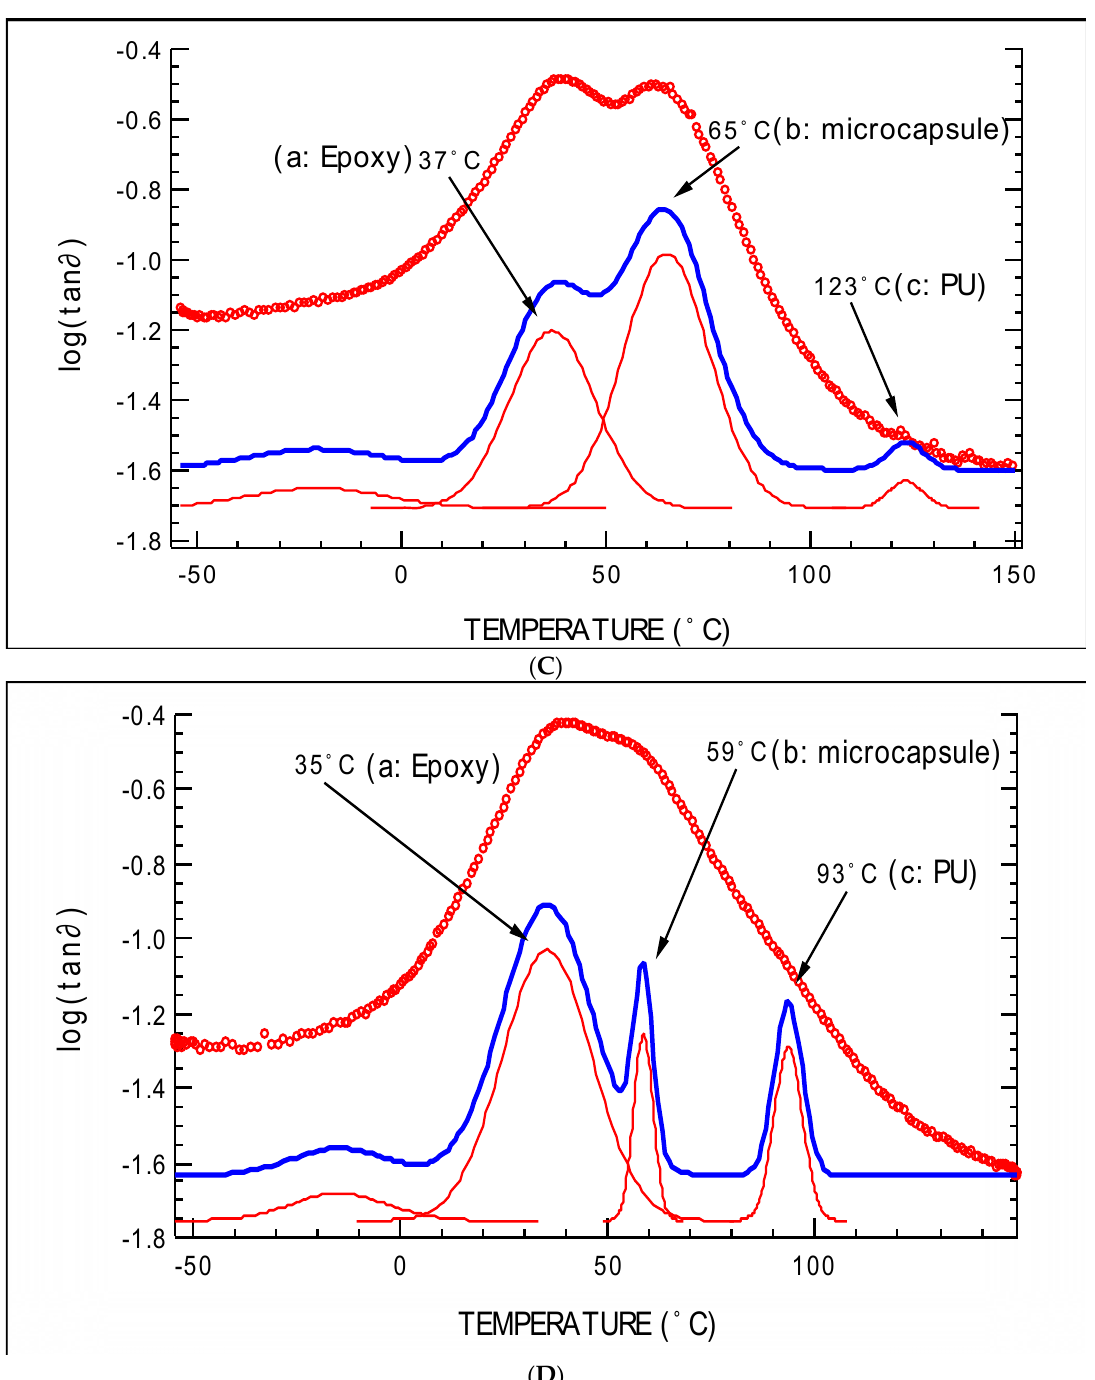
Figure 7. ( A ) Comparison of the storage modulus of pure epoxy with epoxy filled with microcapsules synthesized using varying water:oil ratios. Storage modulus of: (a) pure epoxy; (b) W:O = 4.5:1; (c) W:O = 5:1; (d) W:O = 5.5:1. ( B ) Gaussian fitting of log (tan( ∂ )) of epoxy filled with microcapsules synthesized using a water:oil ratio of 4.5:1. Peak due to: (a) epoxy; (b) microcapsule; (c) PU/epoxy interaction. ( C ) Gaussian fitting of log (tan( ∂ )) of epoxy filled with microcapsules synthesized using a water:oil ratio of 5:1. Peak due to: (a) epoxy; (b) microcapsule; (c) PU/epoxy interaction. ( D ) Gaussian fitting of log (tan( ∂ )) of epoxy filled with microcapsules synthesized using a water:oil ratio of 5.5:1. Peak due to: (a) epoxy; (b) microcapsule; (c) PU/epoxy interaction. A multi-cycle DMA was conducted for an epoxy/microcapsule system with a water- to-oil ratio of 5.5:1 (Figure 8A,B). The broad tan δ peak was resolved into three peaks